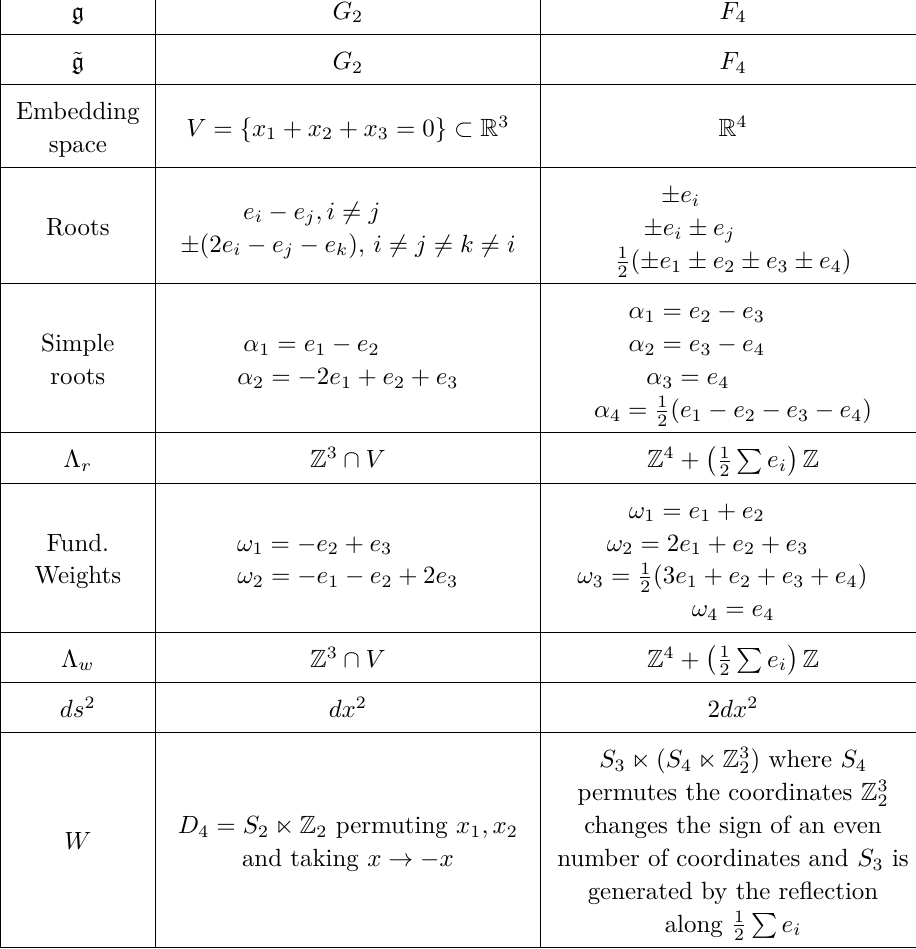
Table 7 . Description and properties of the G 2 and F 4 root